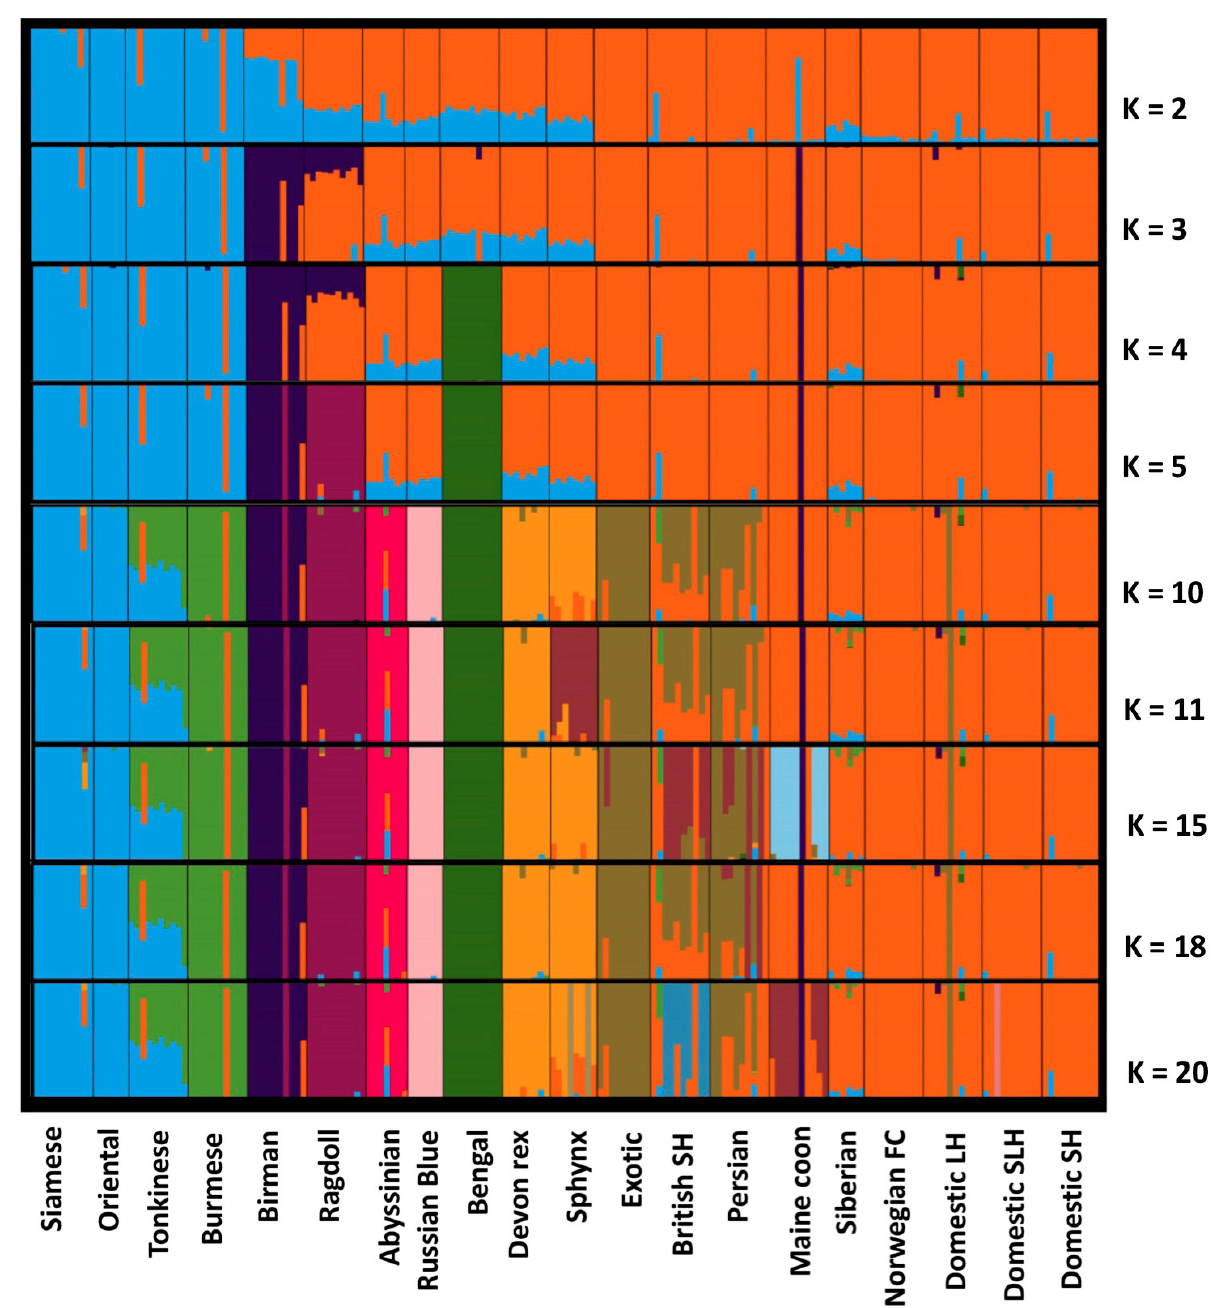
Figure A5. fastSTRUCTURE analysis on the balanced dataset. Each column represents an individual cat. Each cluster (K) is represented by a unique colour. The model complexity maximizing marginal likelihood was K= 10. Model components used to explain structure in the dataset ( K ∅ c ) was K = 11. This suggests that 11 is the minimum number of populations in the balanced dataset that have a cumulative ancestry contribution of at least 99.99%.